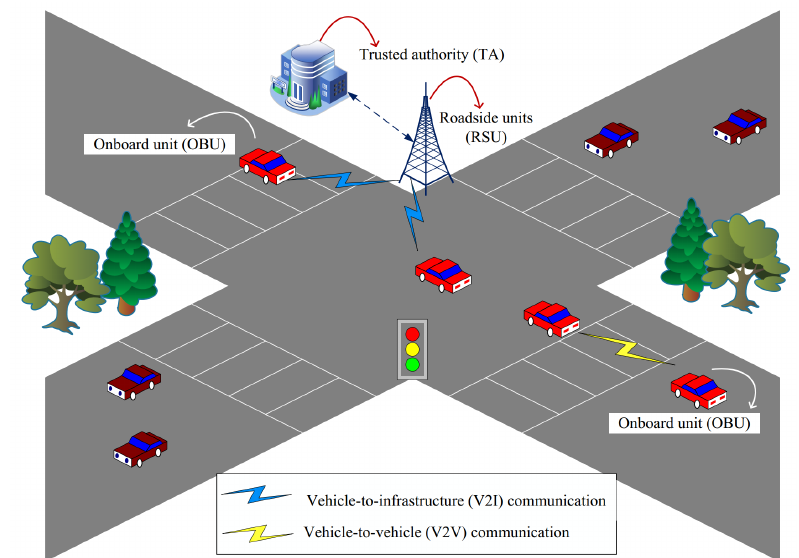
Figure 1. A vehicular ad hoc